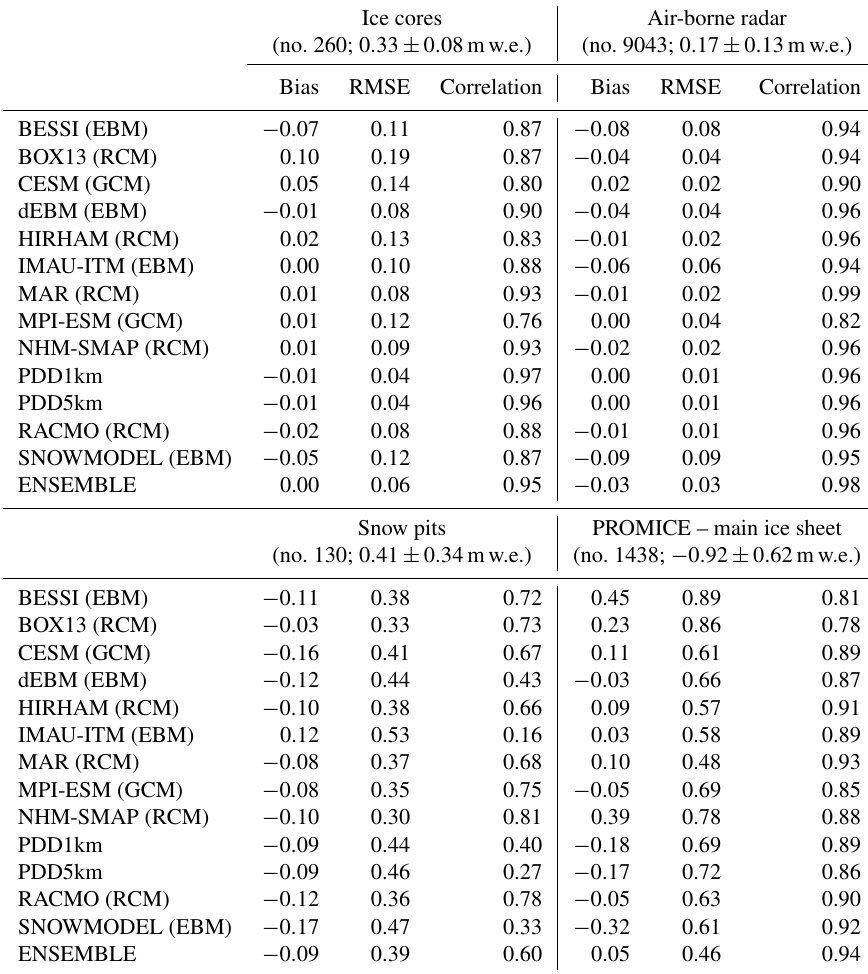
Table 3. Statistics (in mw.e.) of models vs. SMB databases described in Sect. 3. The number of measurements as well as the mean value and the standard deviation around this mean value for each data set is listed in the titles of the table. Finally, except for both PDD models, the statistics of models vs. the SMB PROMICE database over the main ice sheet or the peripheral ice caps from the common ice sheet mask are given in Table S1 in the